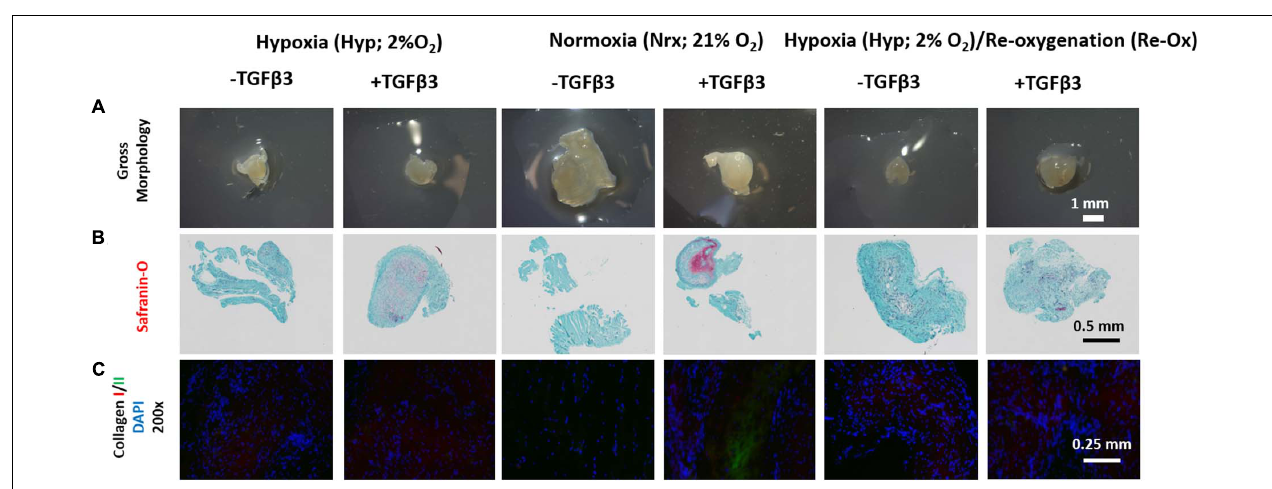
FIGURE 7 | Gross morphology of IFP-MSC pellets after 3 weeks of in vivo implantation in nude mice; Safranin O histochemical staining and immunofluorescence (IF) for types I and II collagen. (A) Gross morphology of pellets; (B) Safranin O staining; (C) IF for collagen I, II, and DAPI, for cell nuclei ( × 200 magnification). All Safranin O and immunostained pellet sections were prepared at 5 µ